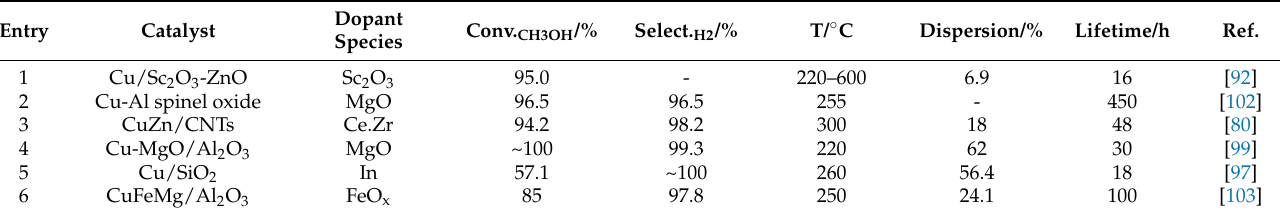
Figure 5. Cu-MgO/Al 2 O 3 bifunctional catalyst for methanol steam reforming: ( a ) The level of CO 2 adsorption and desorption of different catalysts. ( b ) methanol conversion and H 2 selectivity in MSR over time for different samples. ( c ) catalytic performance of 8 wt% Cu/Al 2 O 3 and 0 wt% Cu-MgO/Al 2 O 3 mechanical mixture within 10 cycles. ( d ) catalytic performance of the 8 wt% Cu- MgO/Al 2 O 3 catalyst within 10 cycles. Reproduced with permission [99]. Copyright Elsevier, 2020. Table 2. Copper-based catalysts doped with different promoters for